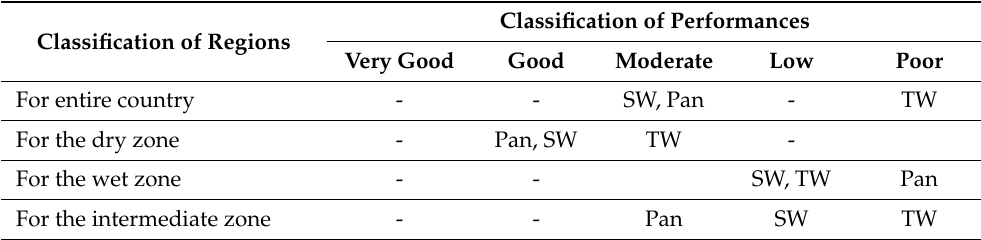
Table 6. Performances of each method with respect to the FAO P–M model in different regions. Ranked from the best to worst, in decreasing order. SW, S–W model; TW, TW model; Pan, pan method. Classification of Performances Classification of Regions Very Good Good Moderate Low Poor For entire country - - SW, Pan - TW For the dry zone - Pan, SW TW - For the wet zone - - SW, TW Pan For the intermediate zone - - Pan SW